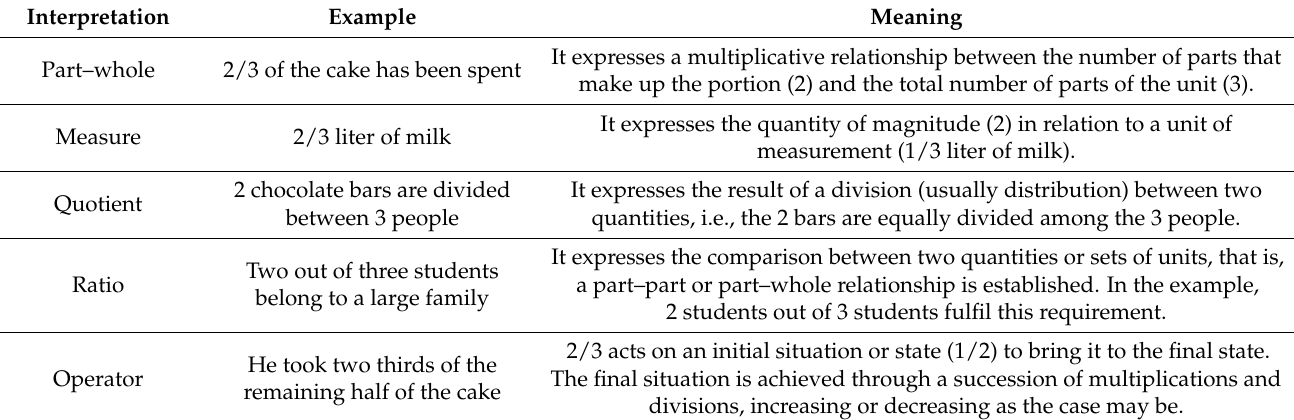
Table 1. Meaning of